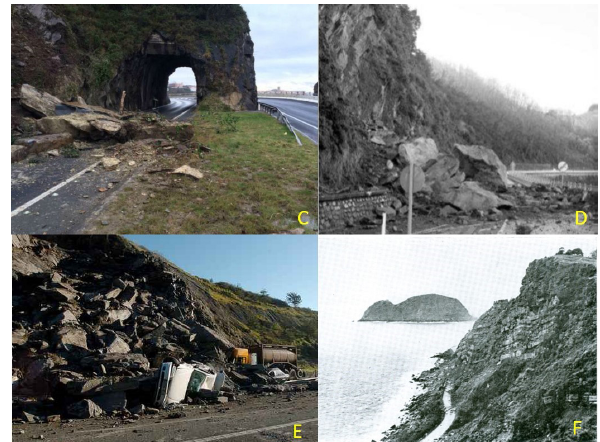
Figure 3. Examples of rockfall magnitudes (C, D, E, F) in the study area in relation to the classes of Table 2 (source: magnitudes C, D, E; Javi Colmenero; F, Servicio Geológico de Obras